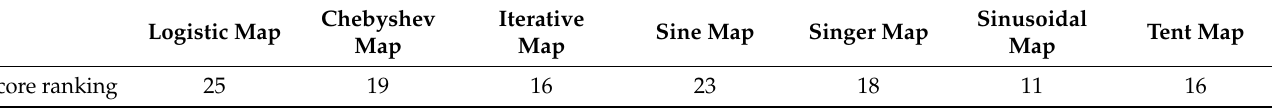
Table 4. Score ranking of seven chaotic functions.